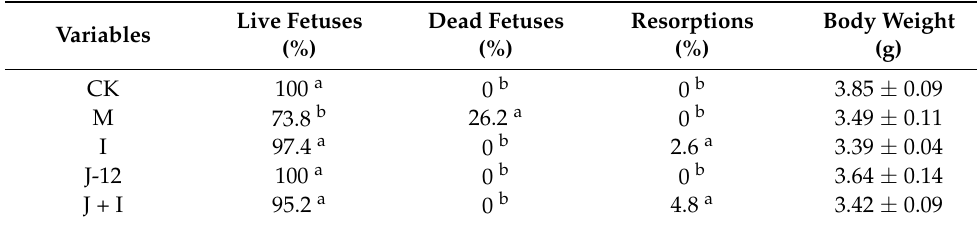
Table 2. Effect of J-12 on physiologic parameters of fetuses.